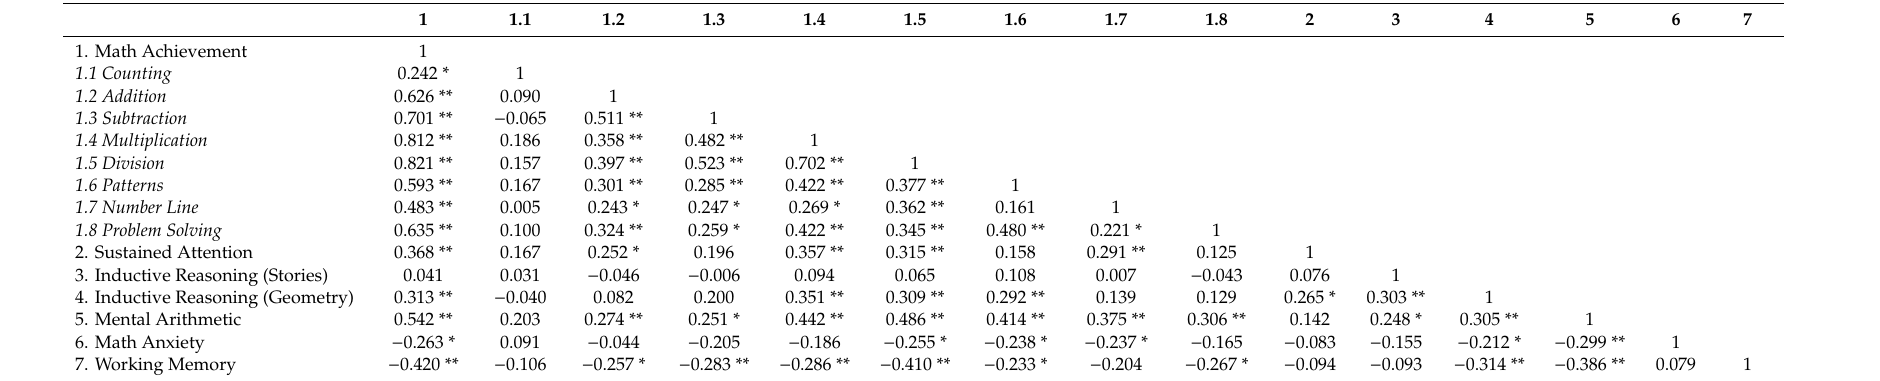
Table 1. Correlation matrix (two-tailed) for mathematical measures, cognitive skills, and math